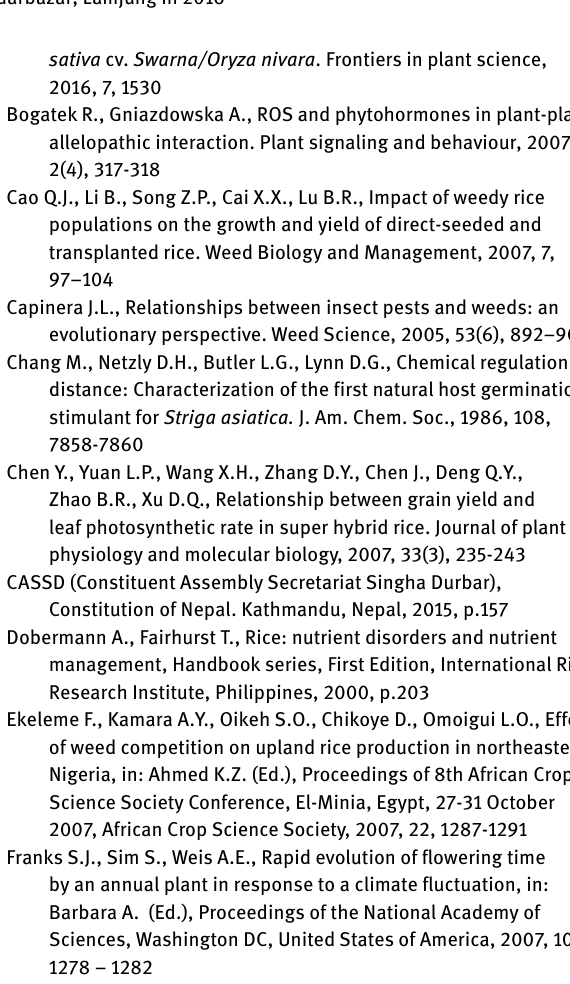
Figure 7: Average weed density of different Rice Genotypes field of Sundarbazar, Lamjung in